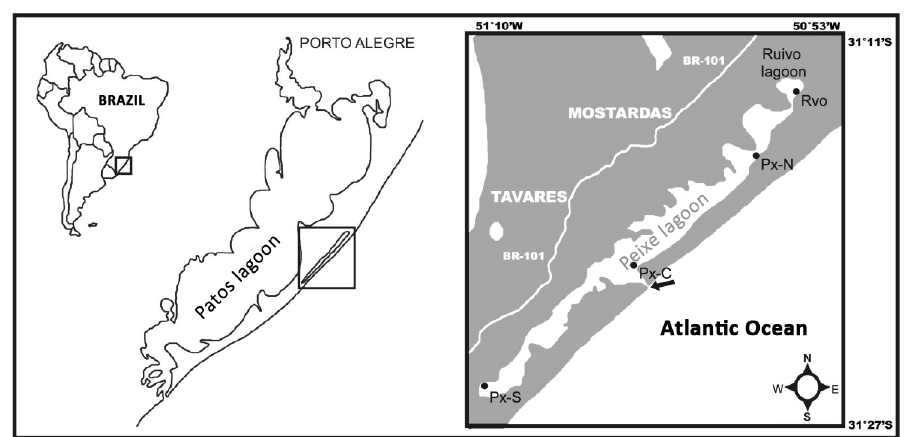
Figure 1 - Map of the Peixe and Ruivo lagoons with sampling locations (Adapted from Loebmann and Vieira 2006), arrow indicates the location of the sand bar. Peixe lagoon, North (Px-N), Center (Px-C), South (Px-S) and Ruivo lagoon